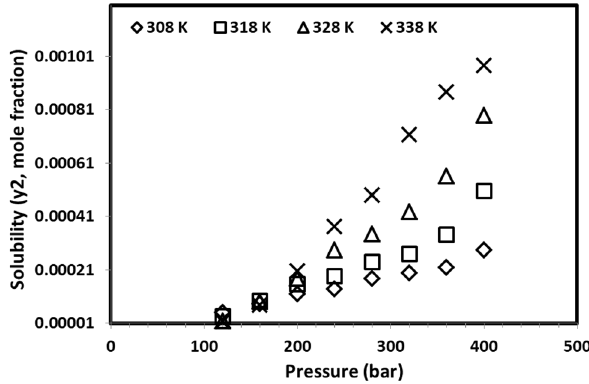
Figure 2. Measured solubility data for decitabine at different pressures and temperatures.